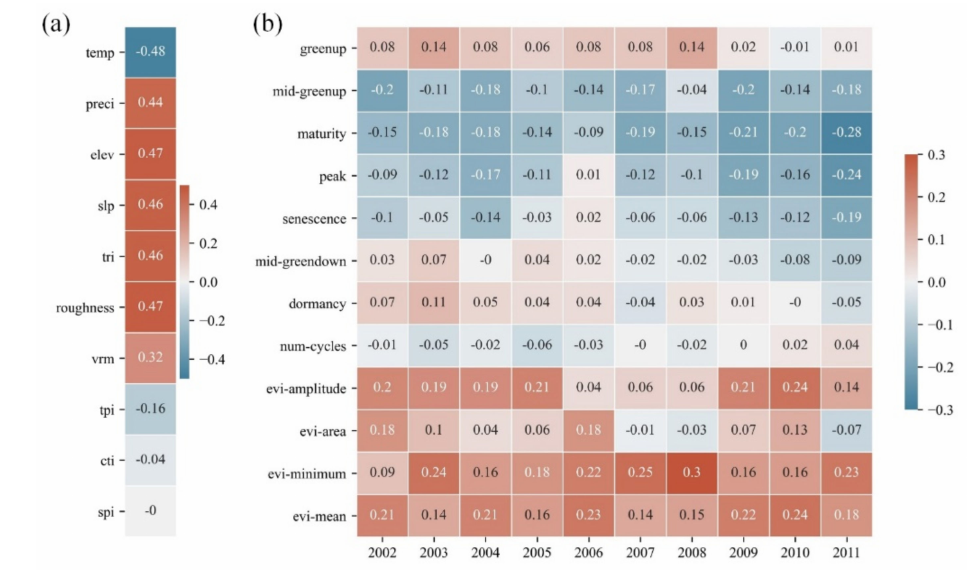
Figure 7. Correlations of soil organic carbon (SOC) content in the year of 2011 with environmental variables in the study area. ( a ) Correlations with climatic and topographic variables; ( b ) correlations with historical phenological and vegetation index variables from 2002 to 2011. The meanings of the abbreviations of all variables can be found in Table